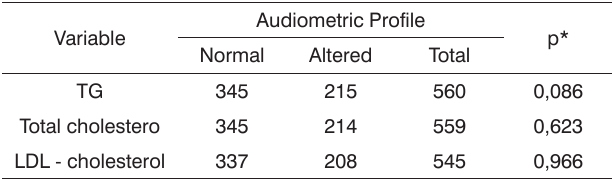
Table 3. Results of the lipid profile and the audiometric profile.